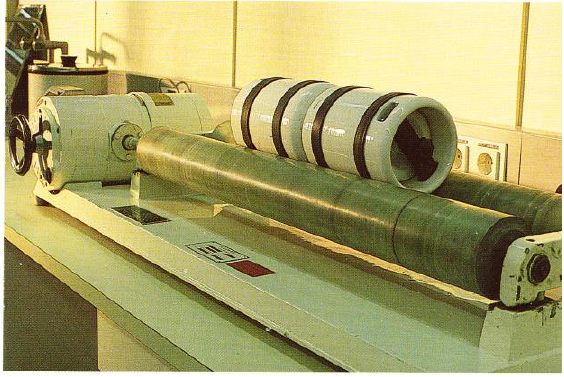
Figure 3. Mixing the W and C powders in the ball